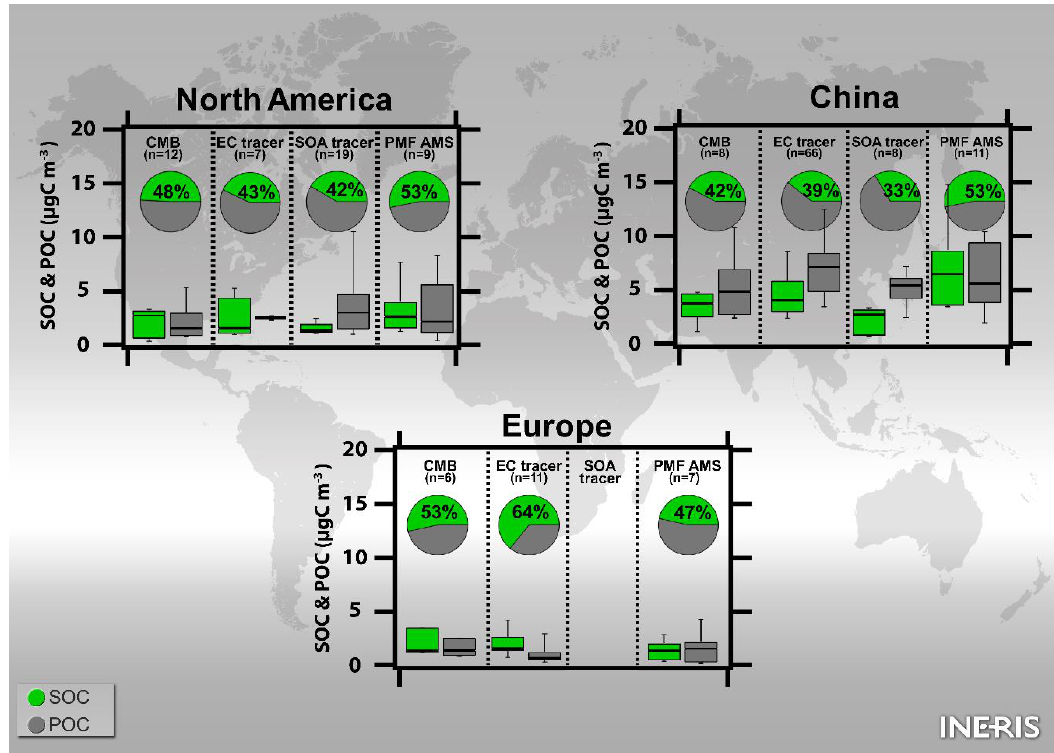
Figure 10. Comparison of spring–summer SOC estimates obtained using CMB, EC tracer method, SOA tracer method (PM 2.5 ) and PMF-AMS (PM 1 ) for North America, Europe and China. Only urban and suburban locations are included. Box-plots show the SOC and POC concentrations (µgC m −3 ) for each continent and each method. Into brackets, number of data points considered. Box plots include minimum (10th), first quartile (25th), median (50th), third quartile (75th) and maximum values (90th).